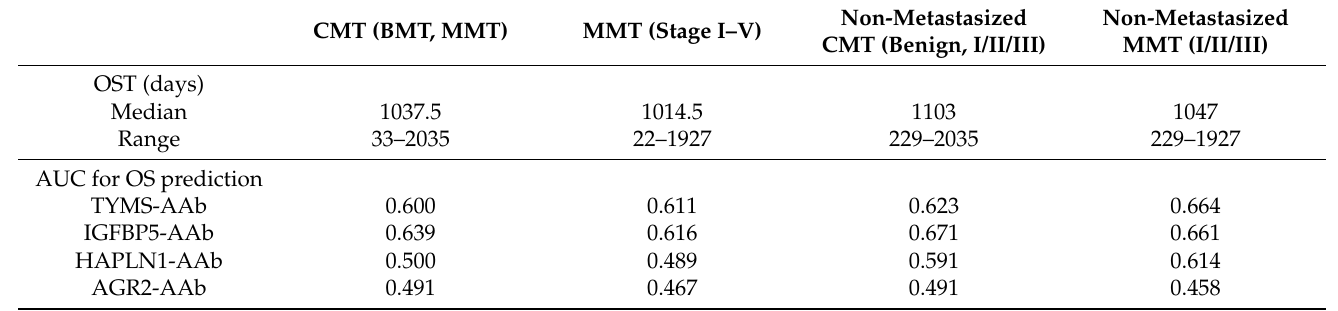
Table 3. Effectiveness of utilizing serum AAb in predicting overall survival (OS) of CMT